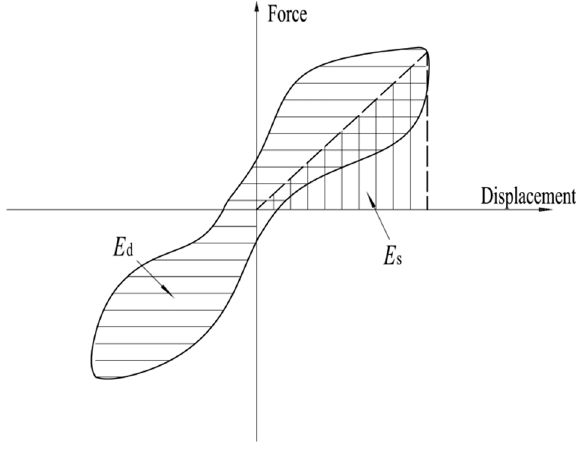
Figure 13. Calculation of energy dissipation.